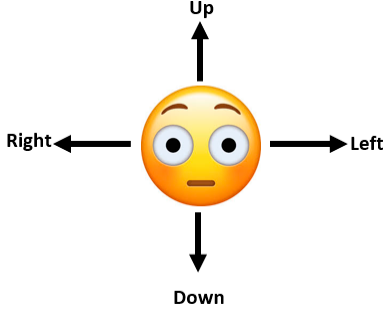
Figure 5. The applied orientations.